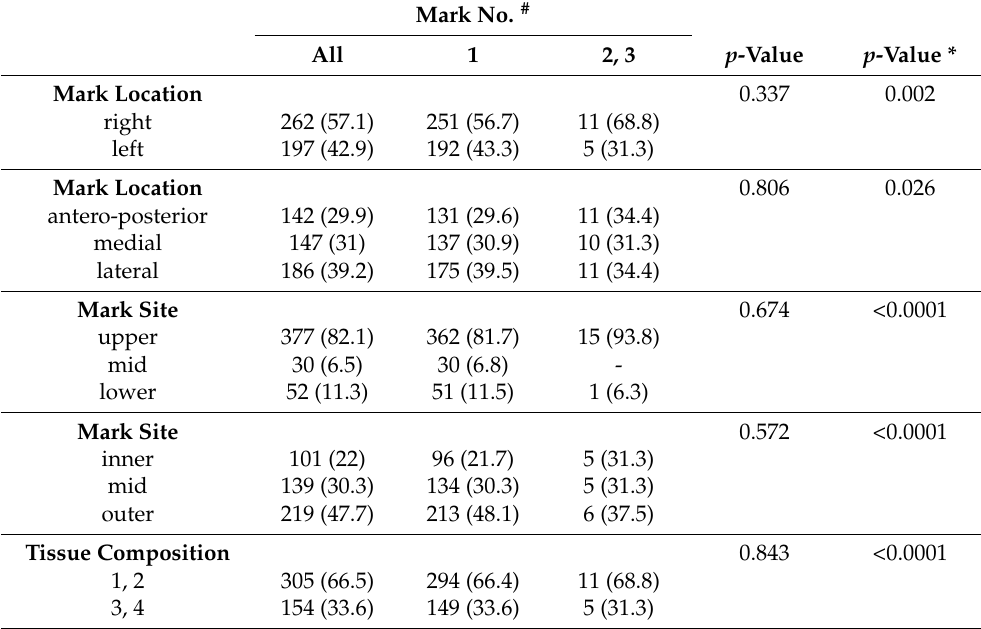
Table 4. Characteristics of false-positive marks associated with pseudolesions (n = 459). Mark No. # p -Value *